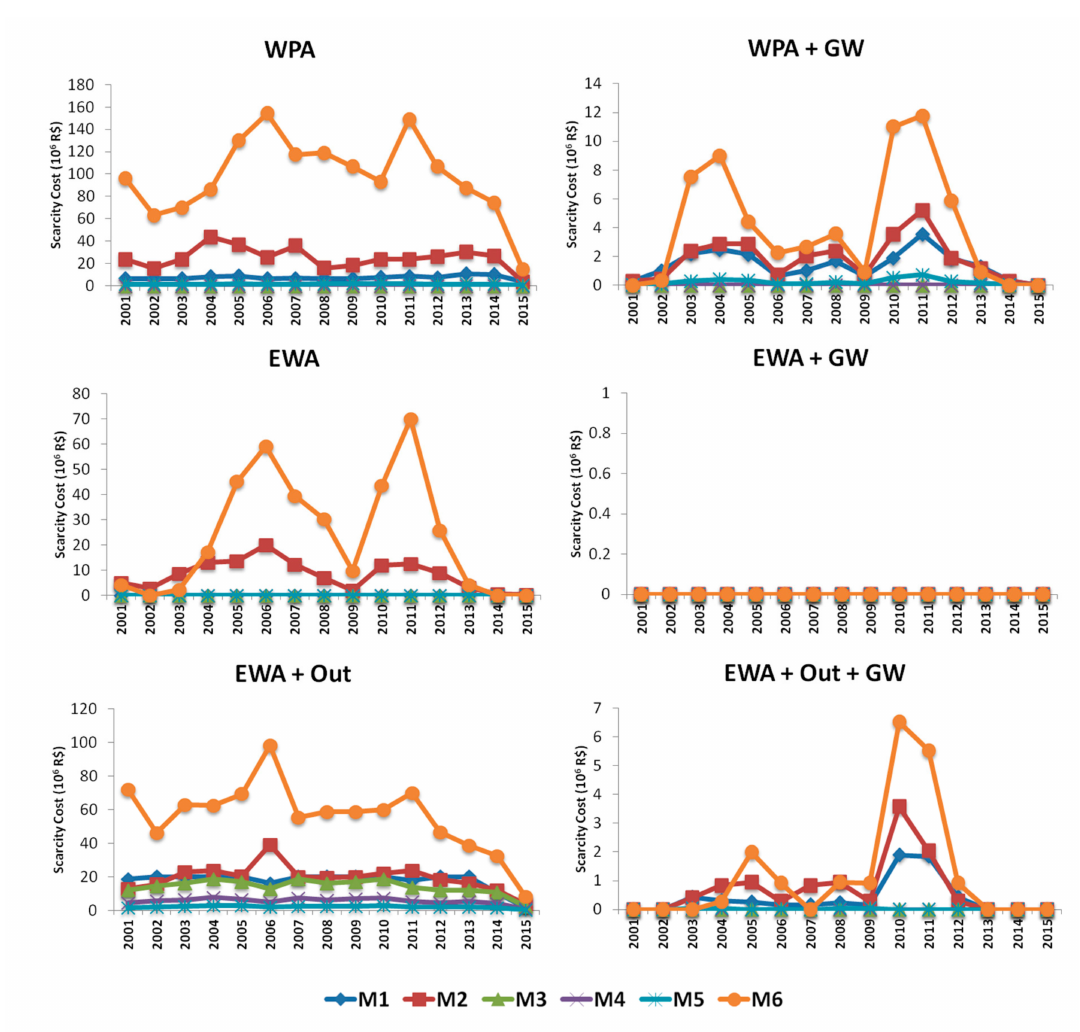
Figure 8. Scarcity cost (10 6 R$) on the six regions in each simulated scenario